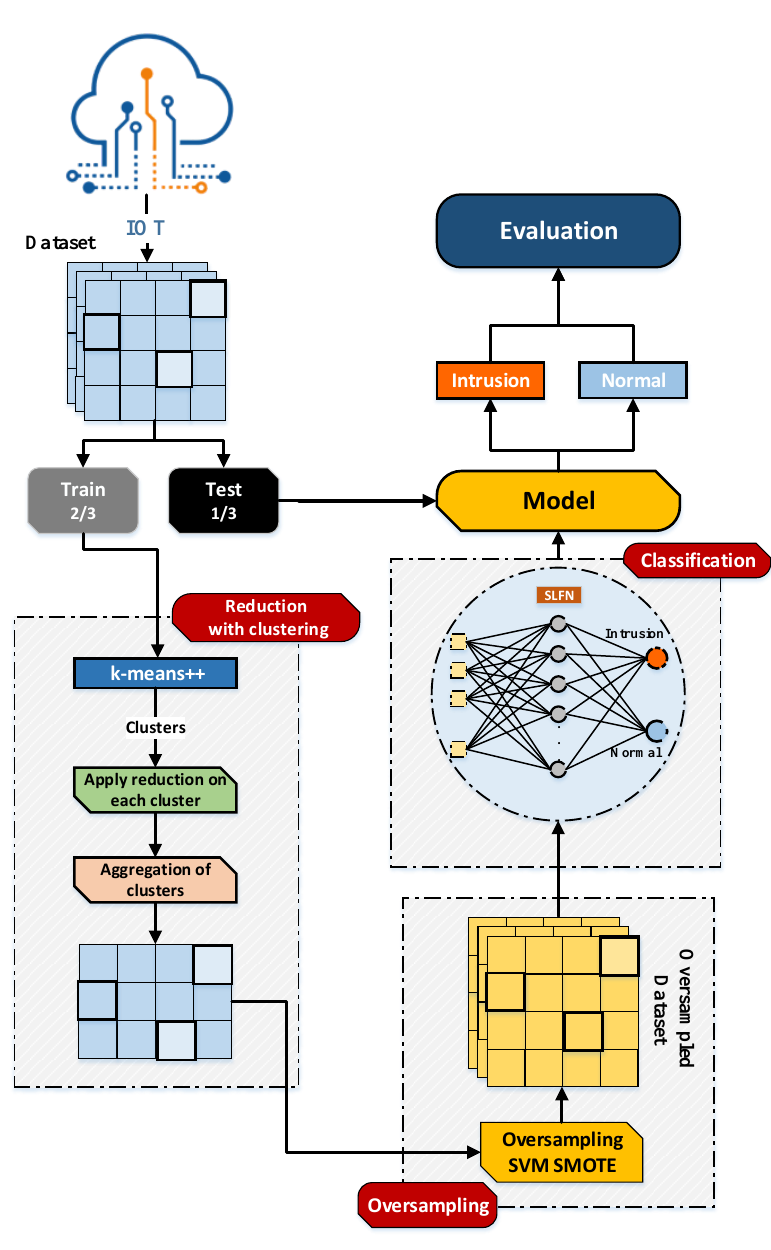
Figure 3. The proposed SLFN-SVM-SMOTE technique including the three stages reduction with clustering, oversampling, and